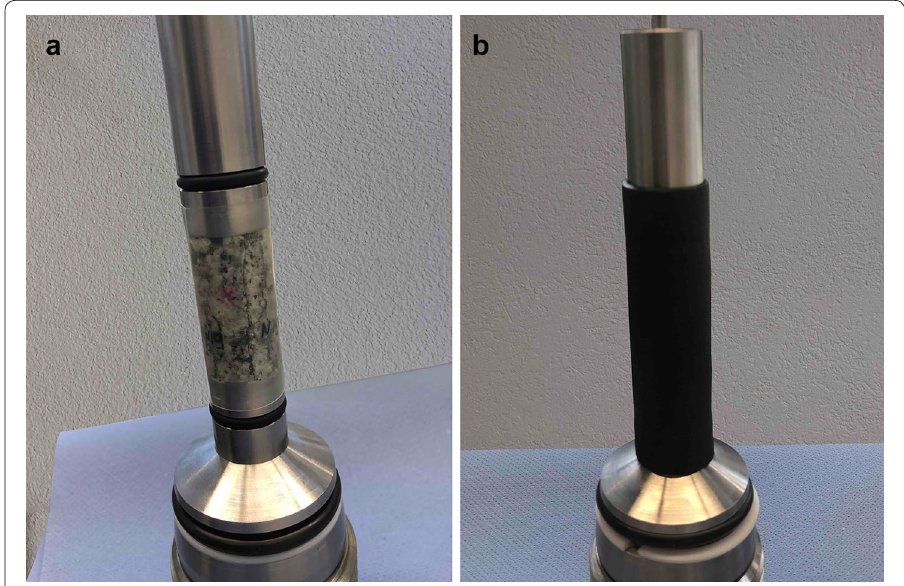
Fig. 5 Fractured specimen confinement. Specimen confined within a heat‑shrinkable and b rubber sleeves, before being placed into the pressure